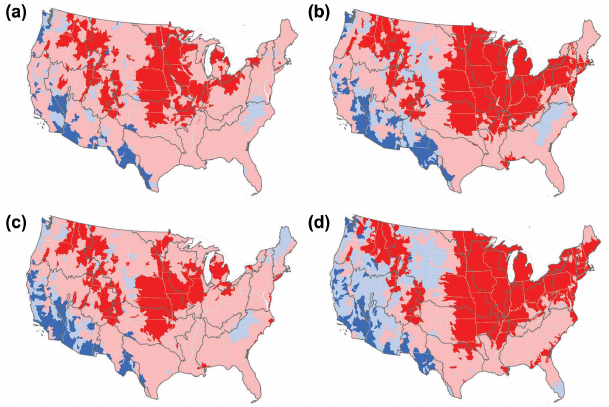
Figure 8. Relative importance of P and T in affecting runoff change across the HUC-8 watersheds in the future scenar- ios of S1 (RCP4.5/2030s) (a), S2 (RCP4.5/2080s) (b) , S3 (RCP8.5/2030s) (c) , and S4 (RCP8.5/2080s) (d) . The watersheds under larger influence of P and T are marked with blue and red colors, respectively. The dark colors denote the areas where 80% or more of the 20 GCMs agree on the sign, while the light colors denote the results of ensemble